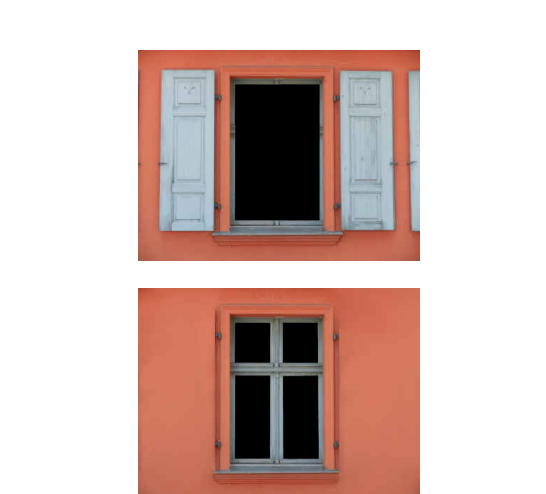
Figure 3. Episodic Memory Task—Windows (1st level of difficulty)–Caption in Greek: Select the image you saw